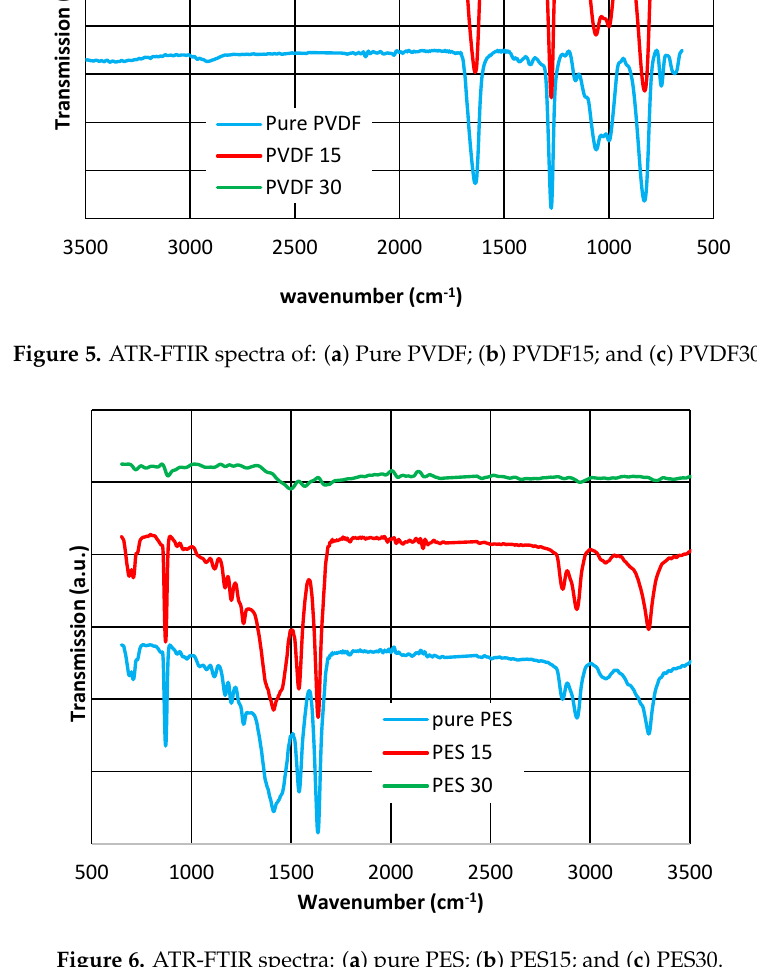
Figure 6. ATR-FTIR spectra: ( a ) pure PES; ( b ) PES15; and ( c ) PES30.